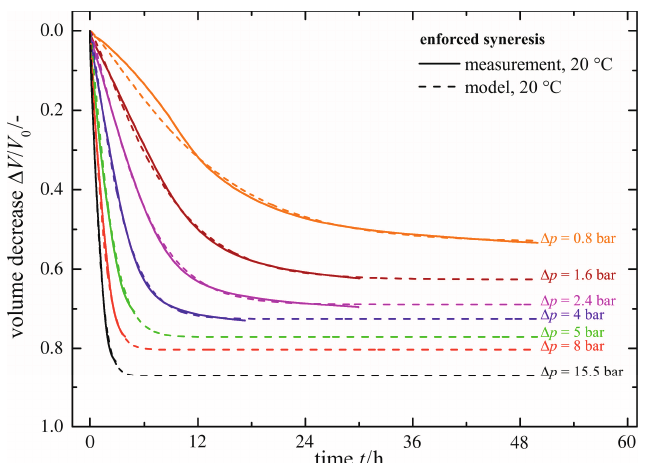
Figure 7. Enforced syneresis for ϑ = 20